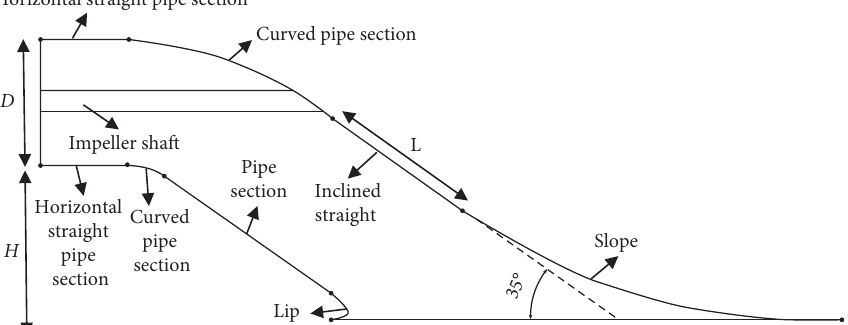
Figure 5: Schematic diagram of the geometric structure of the inlet duct.